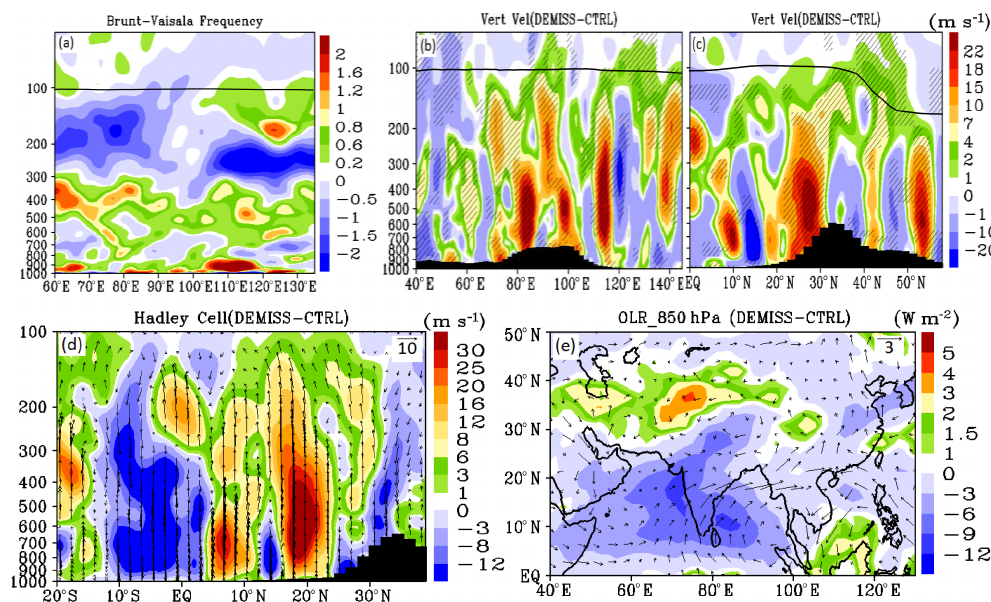
Figure 5. Vertical distribution of anomalies (Demiss-CTRL) averaged for the monsoon season. (a) Square of Brunt–Väisälä frequency (s − 1 × 10 − 5 ) averaged over 25–40 ◦ N and (b) vertical velocities (ms − 1 ) averaged for 15–35 ◦ N. (c) Same as (b) but averaged for 80– 110 ◦ E. (d) Difference in the meridional circulation averaged for 70–90 ◦ E. Black arrows indicate wind vectors. (e) Distribution of outgoing longwave radiation (OLR) (shaded) (Wm − 2 ) and winds (ms − 1 ) at 850hPa. In panels (b–d) the vertical velocity field has been scaled by 1000 and a thick black line shows the tropopause. Black hatched lines in panels (b, c) indicate the 99% confidence